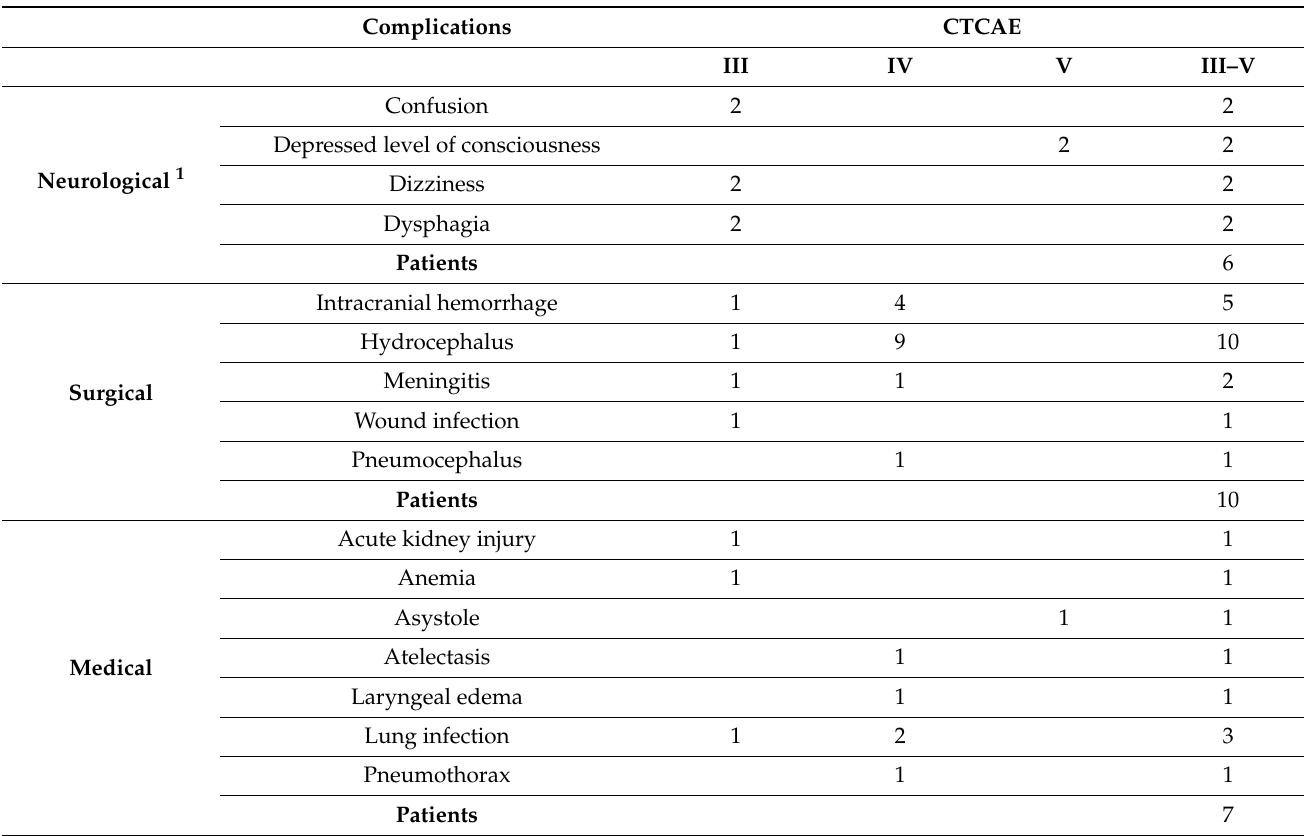
Table 3. CTCAE grades III–V complications following surgery for cerebellar